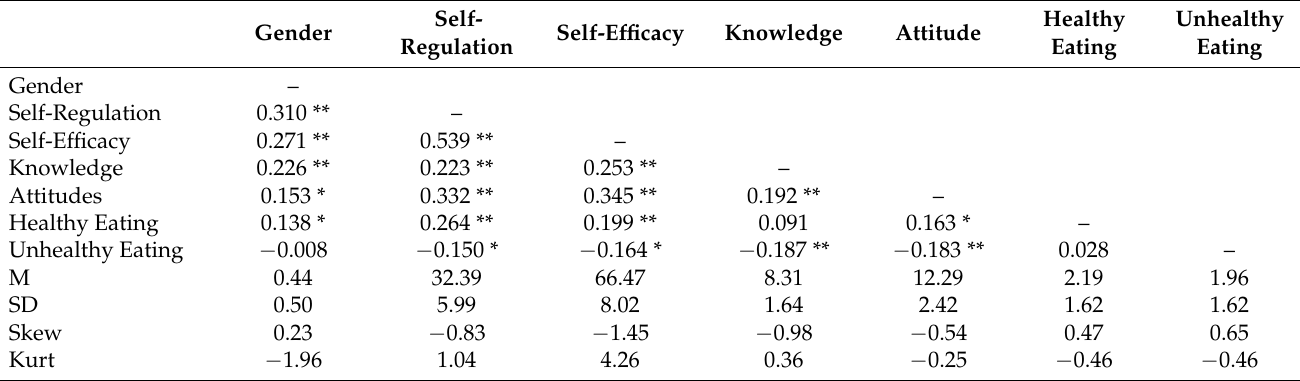
Table 1. Pearson correlations, mean, standard deviation, skewness, and kurtosis of observed measures ( N = 242).